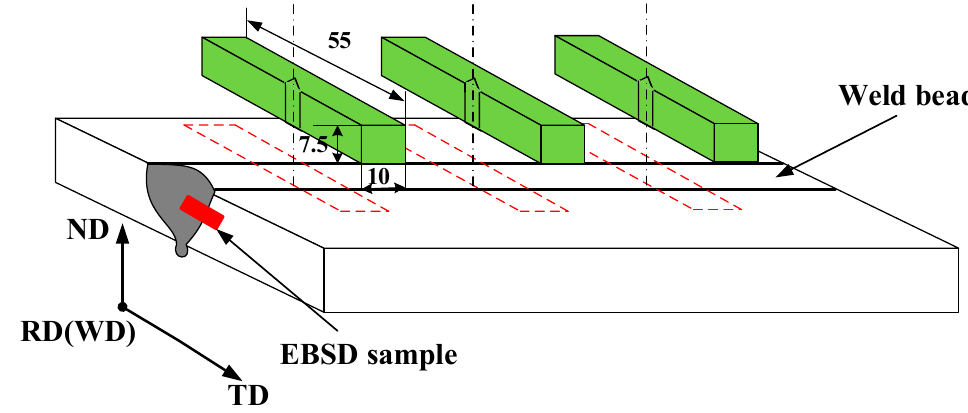
Figure 2. Dimensions of the test specimens (units: mm).